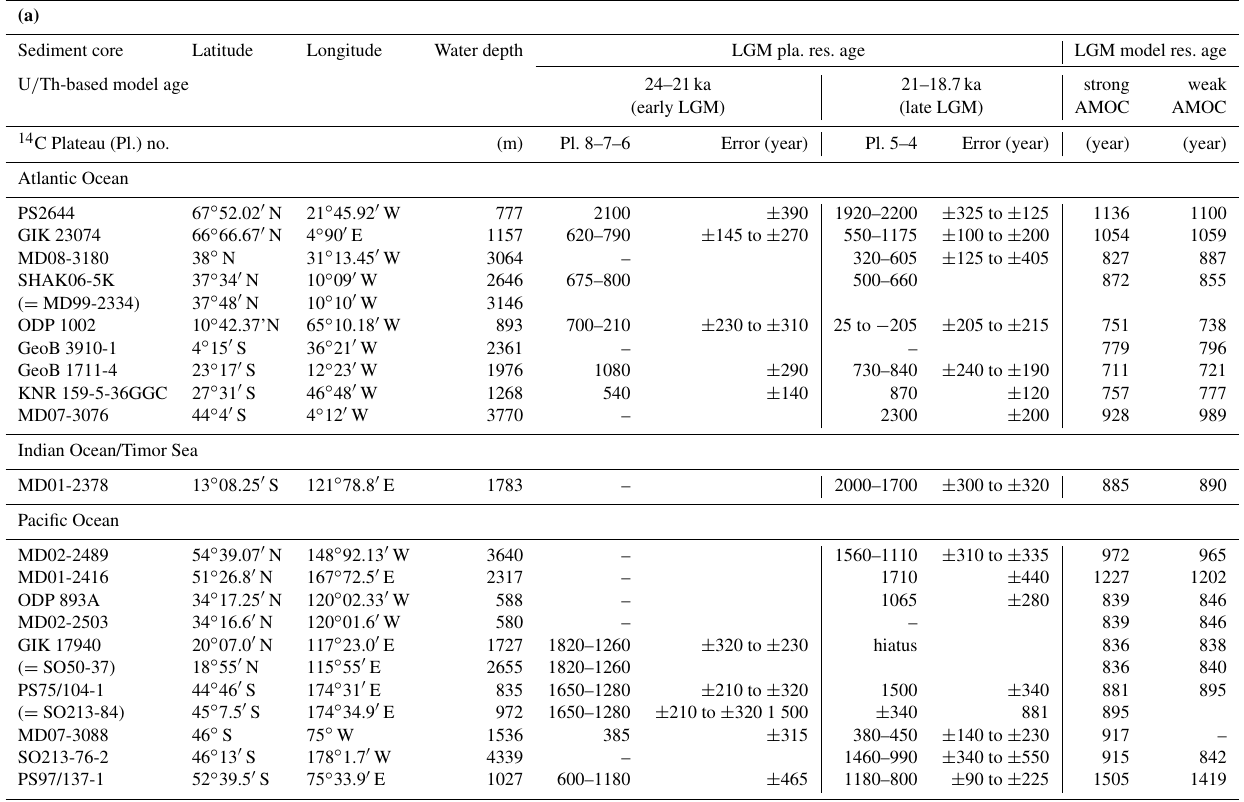
Table 3. (a–c) The 14 C reservoir and ventilation ages of surface (top 50–100m) and bottom waters vs. U / Th-based model age at 19 and 22 core sites in the ocean, respectively. (a) Spatial and temporal changes over the early and late LGM (24–21 and 21–18.7calka), (b) HS-1, and the B/A. Late LGM estimates (average reservoir age of Plateau 4–5) are compared to model-based estimates of Muglia et al. (2018). (c) Data sources. For core locations see Fig.